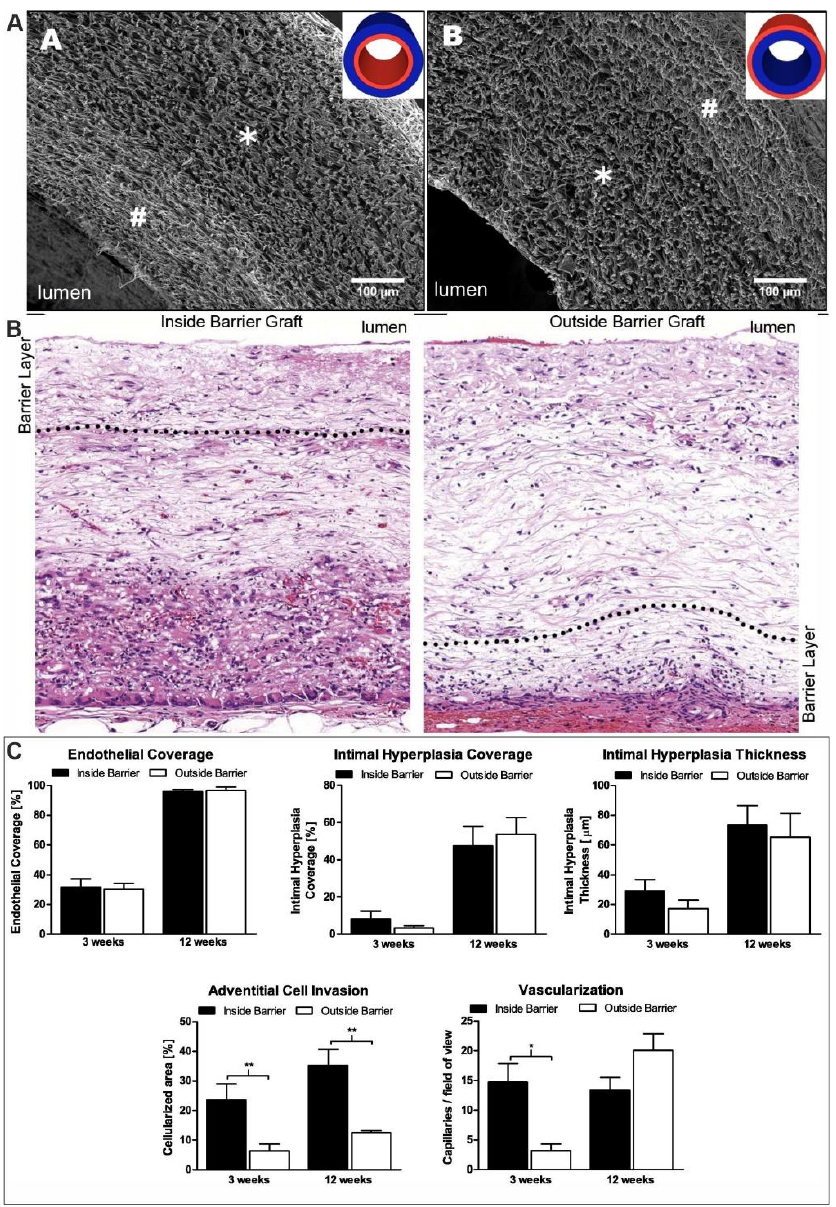
Figure 3. In vivo evaluation of electrospun grafts with a low-porosity layer on either the luminal or the adventitial side (reprinted from Ref. [61]. Copyright © 2012 Acta Materialia Inc. Published by Elsevier Ltd.). SEM images of electrospun vascular grafts ( A ). The low-porosity and high-porosity layers are marked as # and *, respectively. Image of H&E staining of the graft wall after 12 weeks’ implantation ( B ). Morphometric parameters of vascular grafts after 3 and 12 weeks of implantation in the rat abdominal aorta ( C ). The adventitial cell invasion is indicated by ** p < 0.01; vascularization is indicated by * p = 0.016.